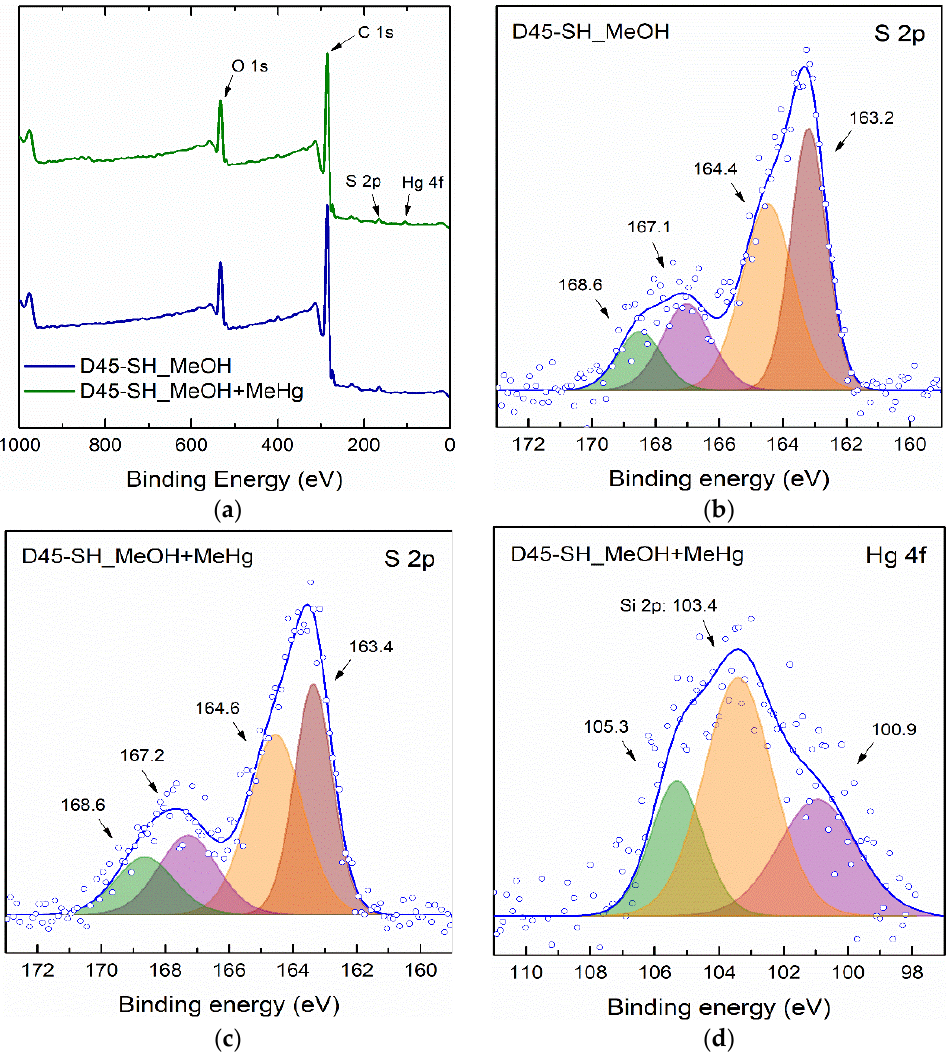
Figure 4. XPS spectra of D45-SH_MeOH material before and after the MeHg adsorption; ( a ) high- resolution S 2p core-level spectra of this material ( b ) before and ( c ) after the MeHg adsorption, and the Hg 4f core-level spectra of D45-SH_MeOH material after the MeHg adsorption ( d ). The high resolution of S 2p core-level spectra for the D45-SH_MeOH material before and after the MeHg adsorption are presented in Figure 4b,c, respectively. In both cases, the S 2p spectra showed two pair of peaks, which correspond to different sulfur